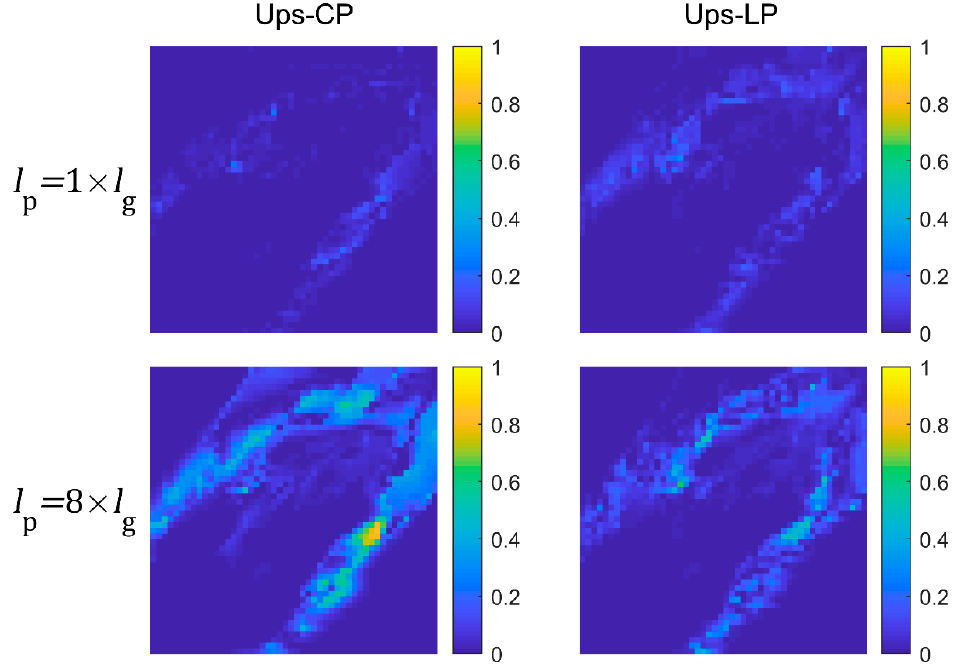
Figure 8. Absolute error of the tracer concentration solutions after 2 PVI for the Ups-CP ( first column ) and Ups-LP ( second column ) models when the partition is l p = l g ( first row ) and l p = 8 × l g ( second row ).